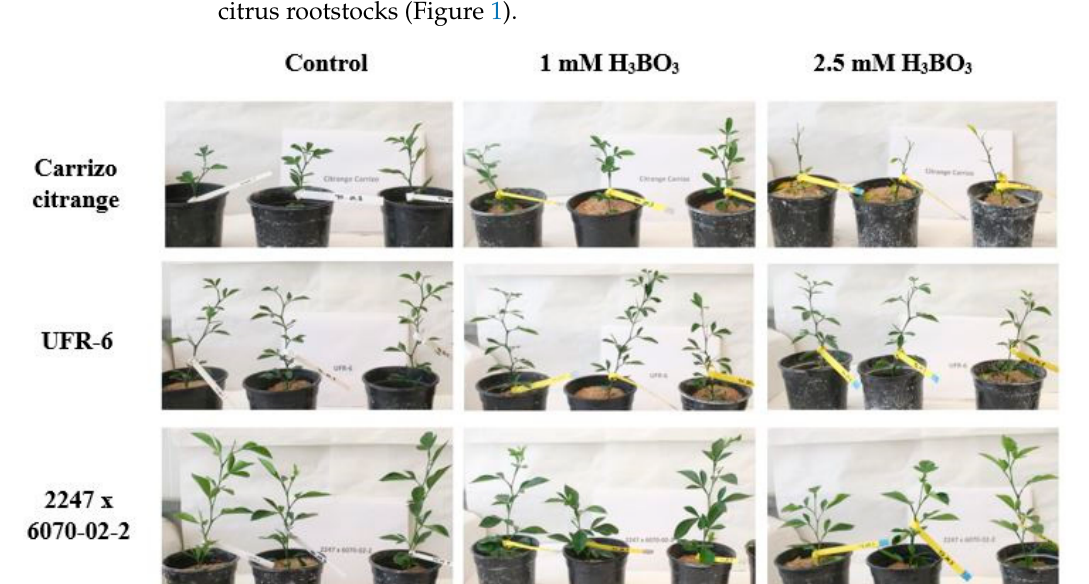
Figure 1. Plant symptoms of the three citrus rootstocks (Carrizo citrange, UFR-6 and 2247 x 6070-02-2) under three boron treatments (Control, 1 mM H 3 BO 3 and 2.5 mM H 3 BO 3 ) at the end of the experiment (21